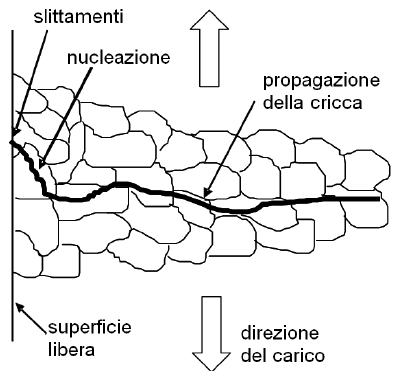
Figura 1: Rappresentazione schematica degli stadi I e II della fatica [1]. Figure 1: I and II fatigue growth stages [1].